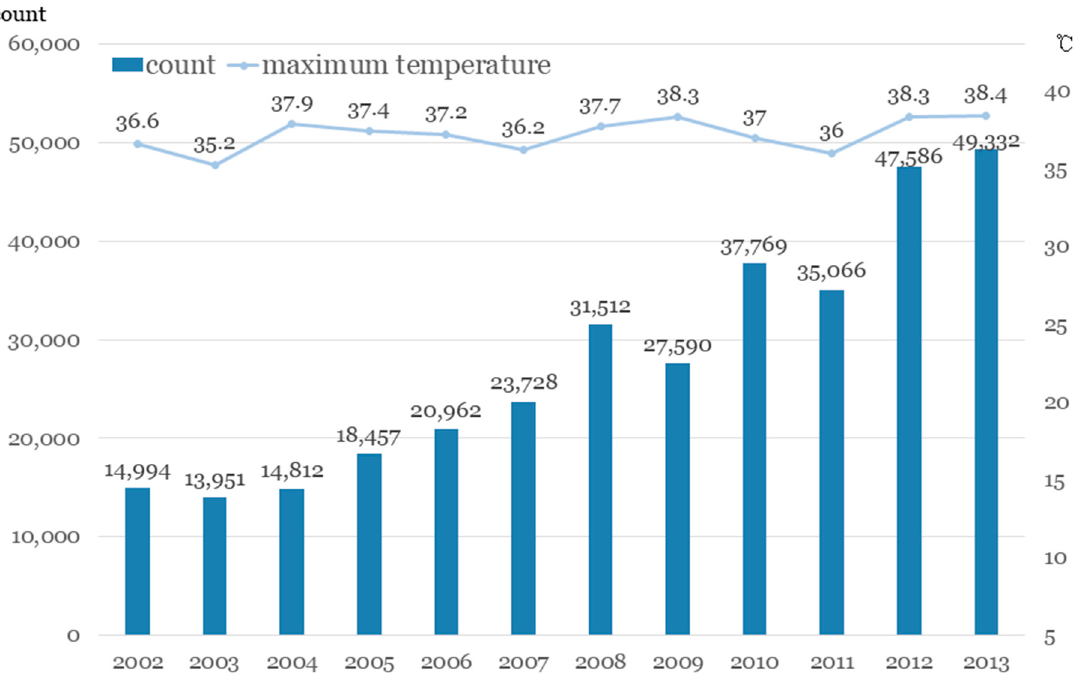
Figure 1. Trend of thermal illness patients and maximum temperature of the year from 2002 to 2013.